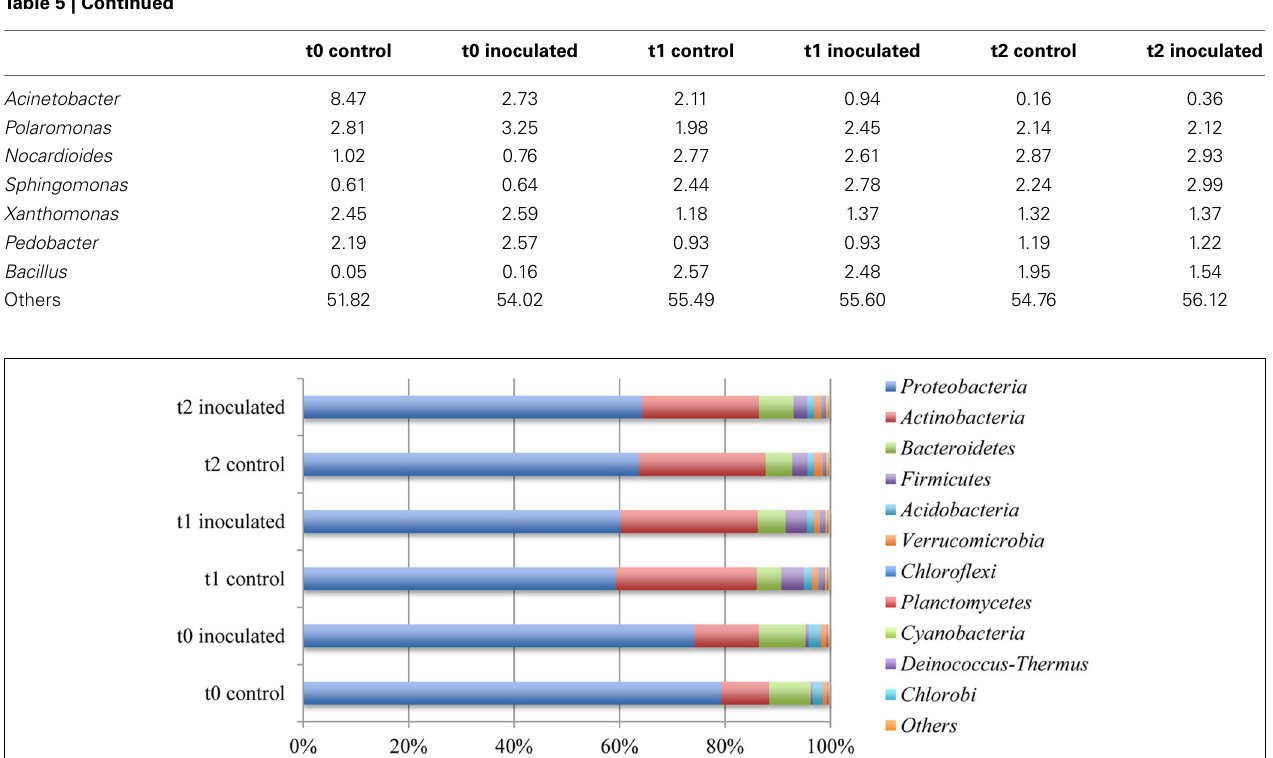
FIGURE 3 | Comparison of the ten most abundant phyla within the rhizosphere of lettuce. Abundances were calculated by means of comparison of metagenome sequence reads against the GenBank database within the MG-RAST software package.